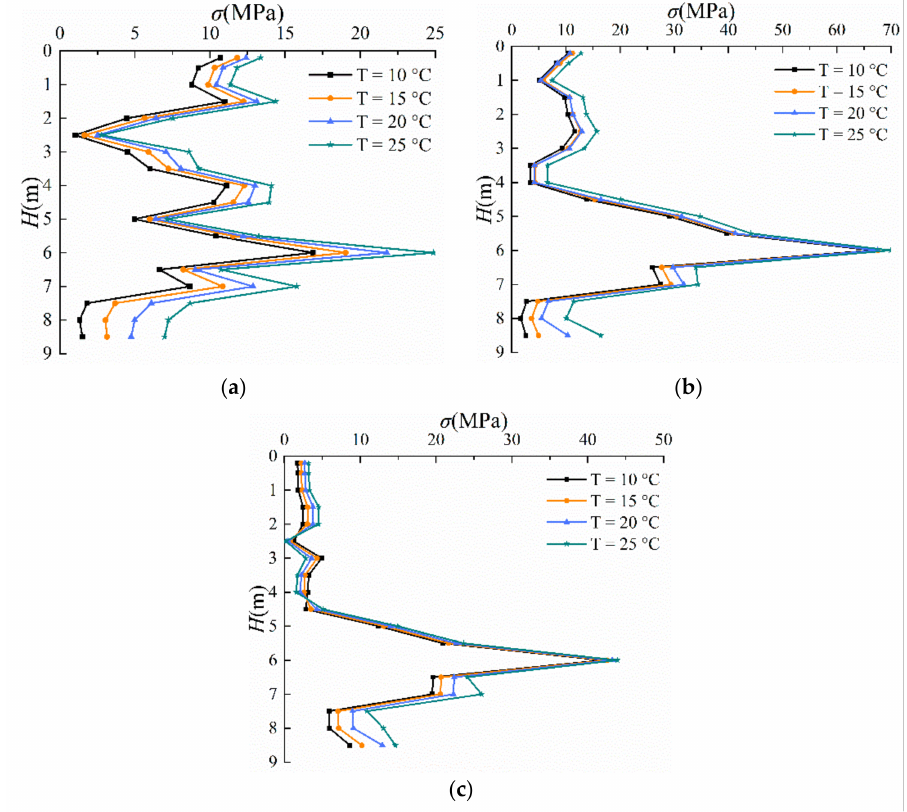
Figure 13. The stress–temperature relationship of ( a ) pile 1, ( b ) pile 2, and ( c ) pile